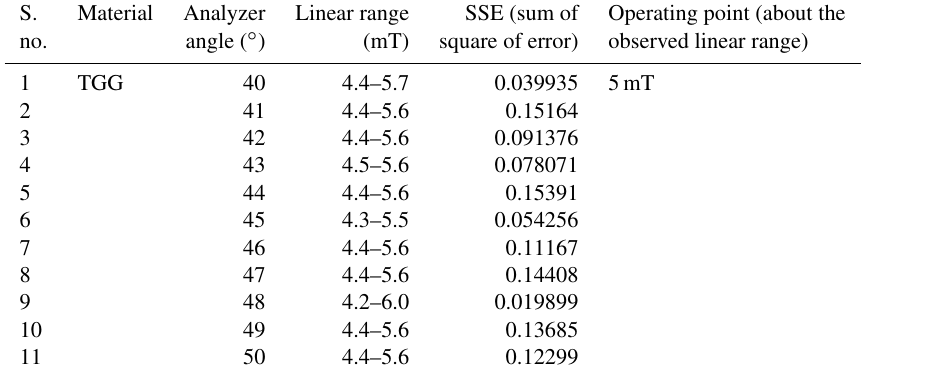
Table 6. Analyzing linear regions of TGG over a magnetic field range of 0–10mT at 532nm wavelength (sample data). S.